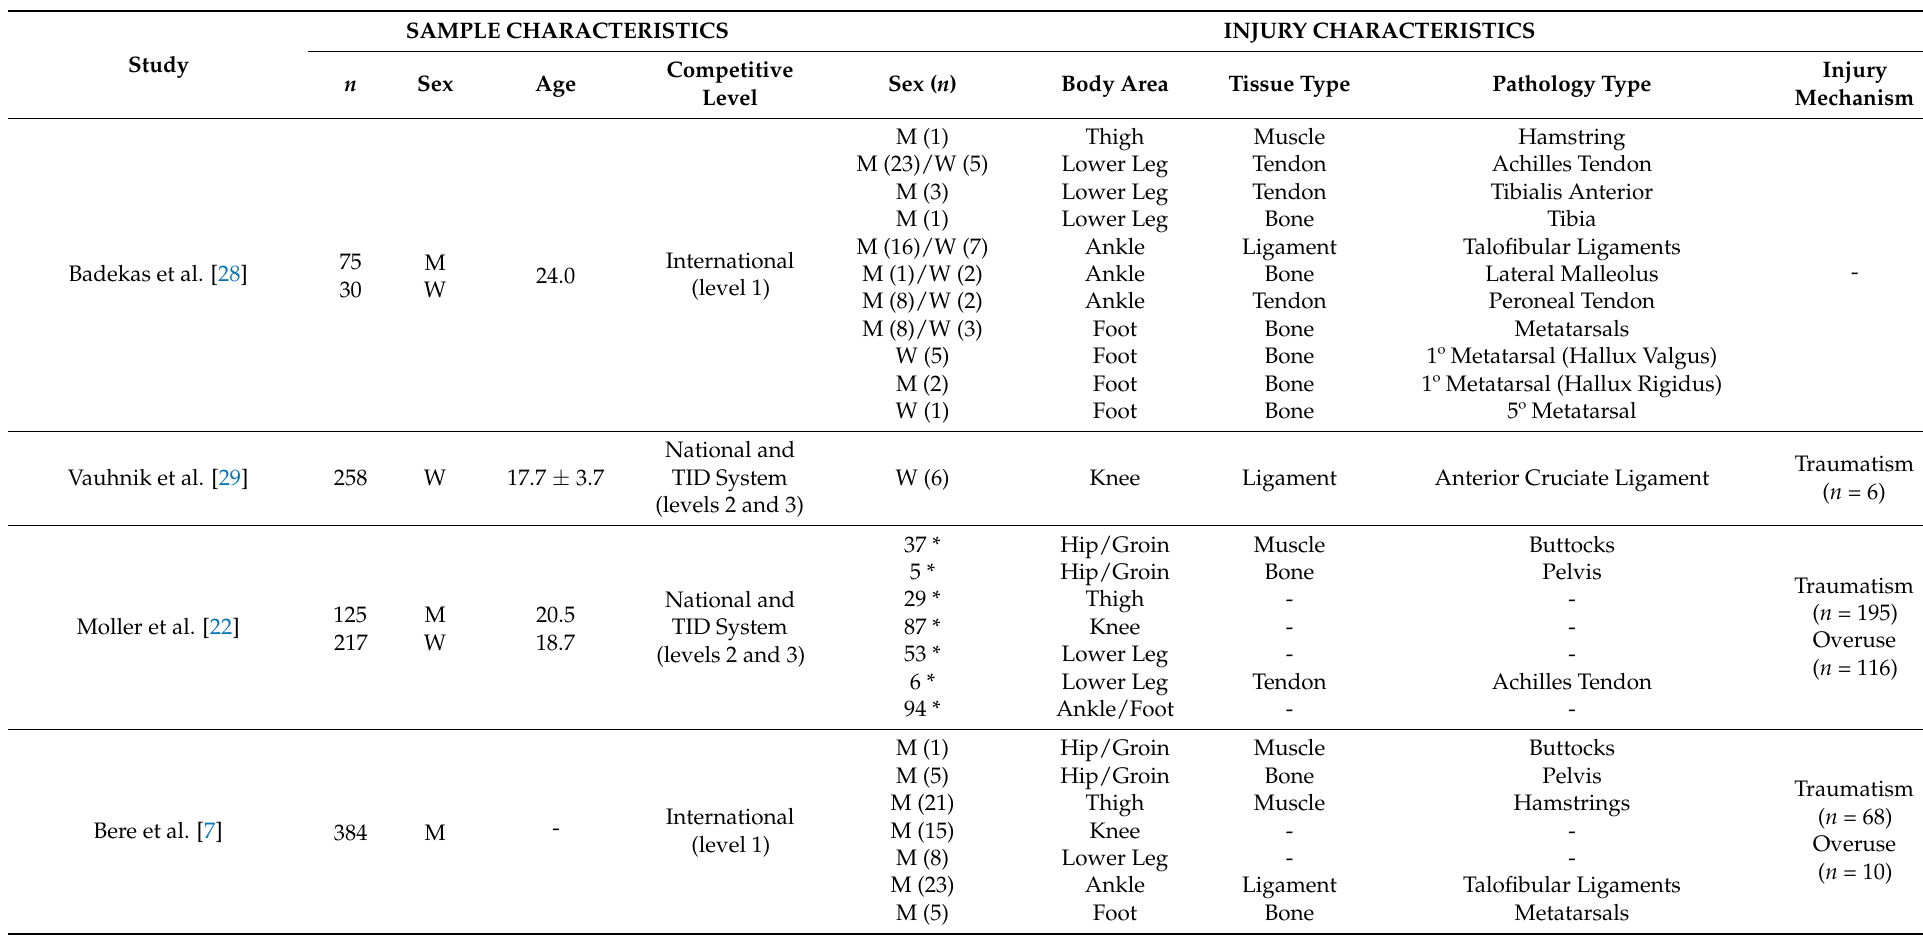
Table 1. Summary of the sample (“ n ”, sex, age, and competitive level) and injury characteristics (“ n ”, body area, tissue type, pathology type, and injury